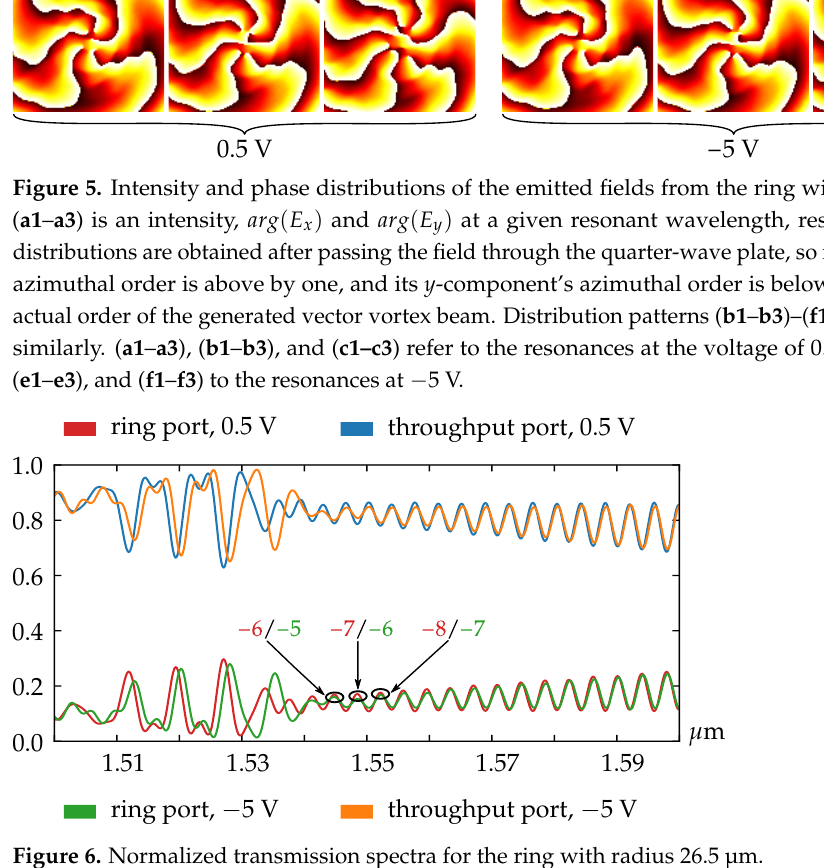
Figure 6. Normalized transmission spectra for the ring with radius 26.5